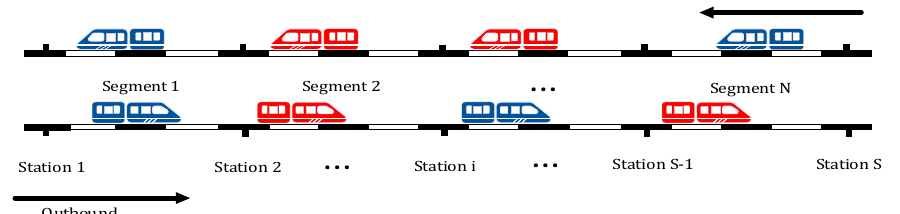
Figure 1. Adding additional train on a railway corridor in the peak period.